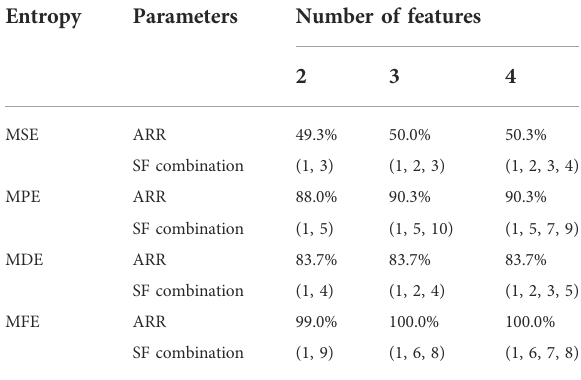
TABLE 5 Highest ARR of four types of entropies for six SRNs under different number of features.